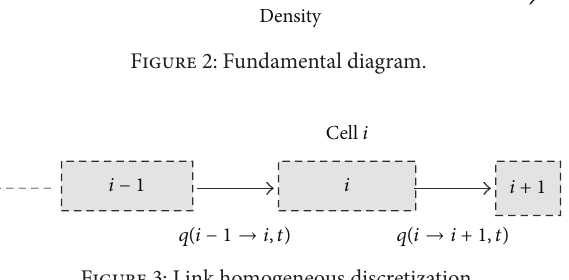
Figure 3: Link homogeneous discretization.